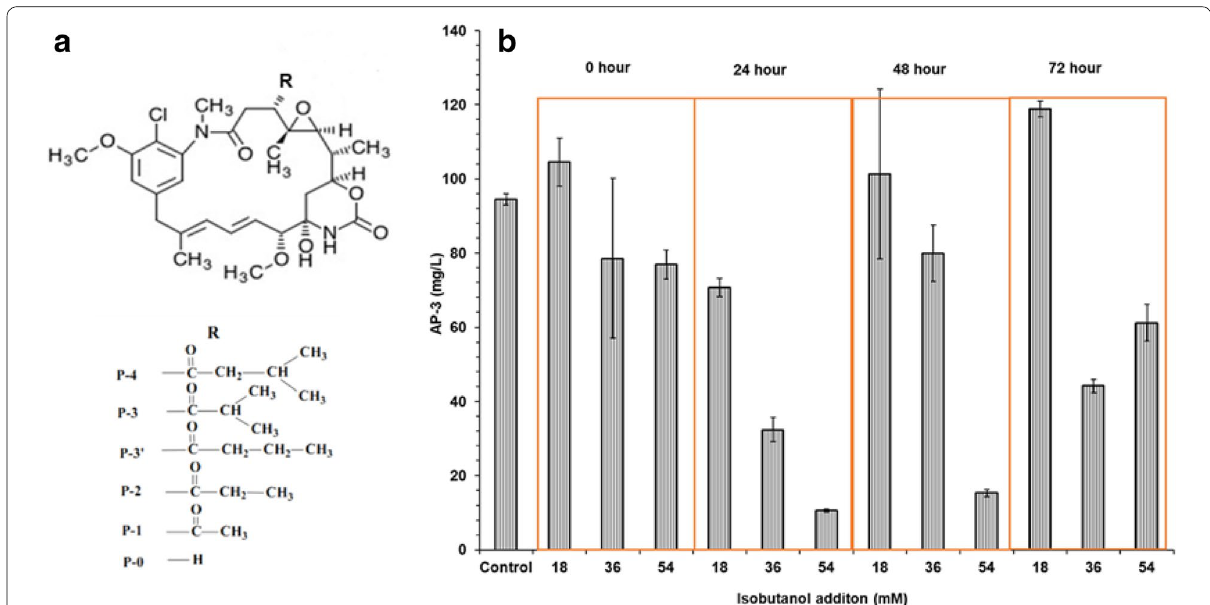
Fig. 4 Production of AP‑3 with isobutanol added at various concentrations and different cultivation times. a Structures of ansamitocins; b effect of isobutanol supplementation on AP‑3 production. 50 mL of optimized medium was loaded in a 250‑mL flask and cultured at 28 °C with a shaking rate of 220 rpm. Isobutanol was added at one of three different final concentrations (18, 36, or 54 mM) at 0 h, 24 h, 48 h, or 72 h of cultivation